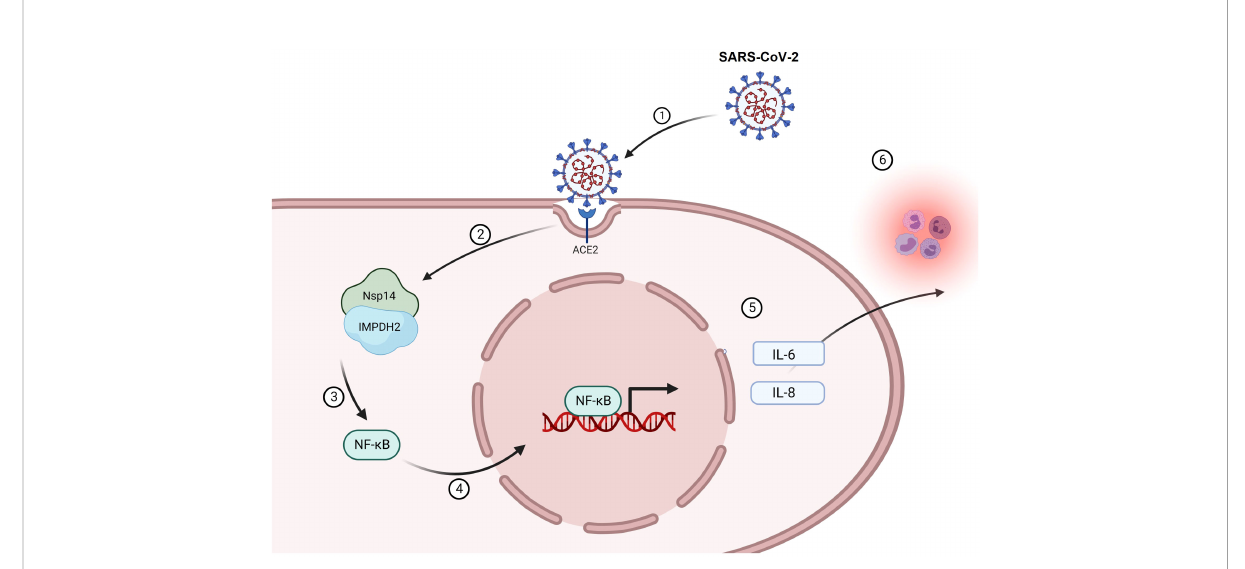
FIGURE 8 A working model of Nsp14-mediated NF- k B activation during SARS-CoV-2 infection. Infection of SARS-CoV-2 (1) leads to the expression of Nsp14 (2) that interacts with IMPDH2 (3). Such interaction promotes the nuclear translocation of NF- k b p65 (4) and its activation, which upregulates the expression of downstream cytokines, including IL-6 and IL-8 (5). Expression of IL-6 and IL-8 may further amplify the in fl ammatory response from immune cells contributing to viral pathology in COVID (6) and also, in return, bene fi t SARS-CoV-2